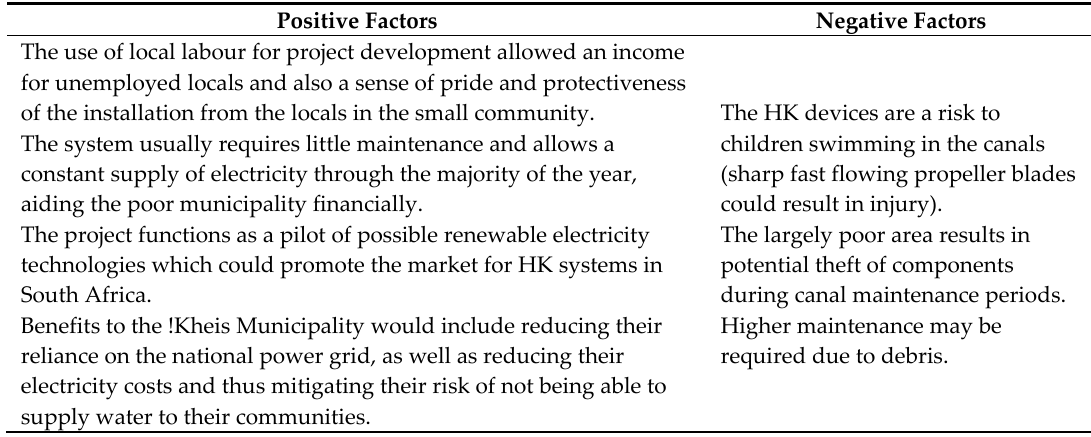
Table 3. HK installation social